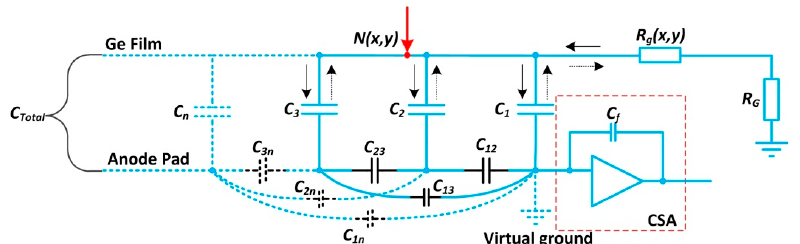
Figure 4. A lumped-parameter presentation of the readout mode for induced charge. C 1 , C 2 , C 3 to C n = the capacitances between the germanium film and each anode pad, respectively. C 12 , C 23 , C 13 to C 1n , C 2n , C 3n = the inter-electrode capacitances for each anode pad. C Total = the capacitance between the germanium film and the virtual ground. N(x,y) represents the electron cloud position to be used in the calculation. R g (x,y) is the germanium film’s surface resistance between any node N(x,y) and the discharged resistance R G .